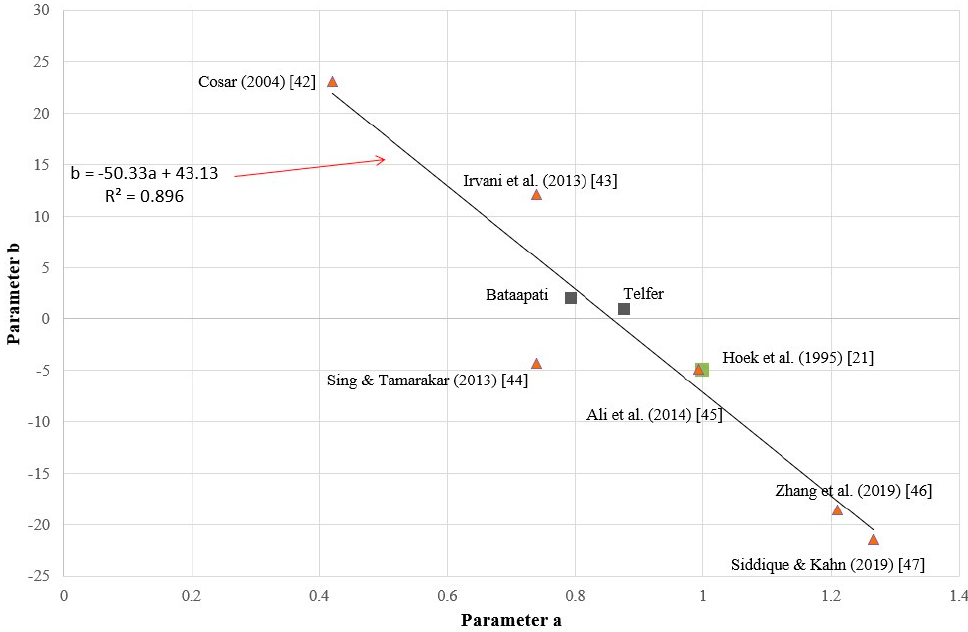
Figure 8. The correlation between different a and b constants regarding different correlations between GSI-RMR 89 values.